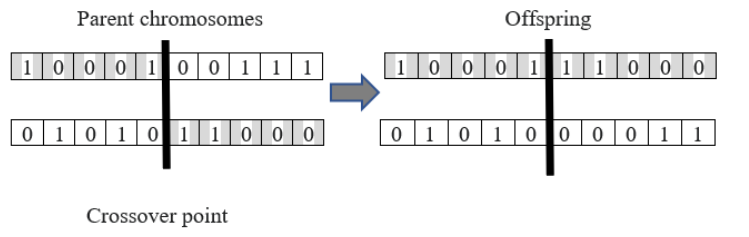
Figure 2. Crossover process in genetic algorithms.